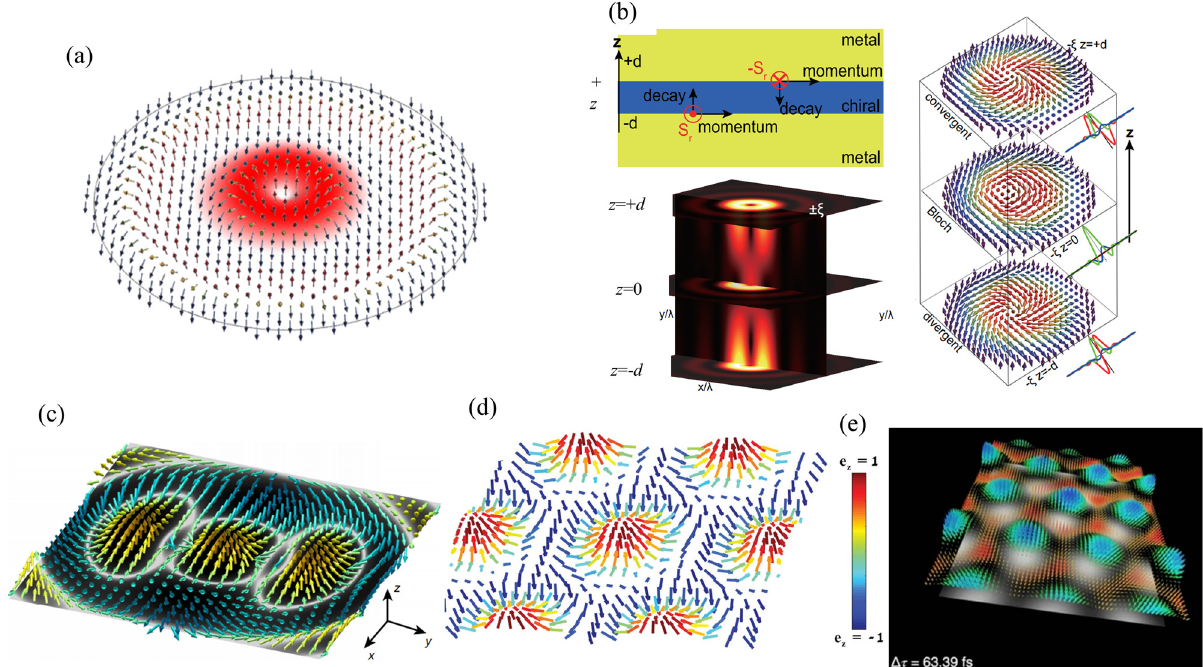
Figure6: Variouskindsof photonictopologicalstructuresinguidedwavesformedinrealspace:(a)Néel-typephotonicspinskyrmionformed in an evanescent optical vortex, for which the spin vector varies progressively from the ‘ up/down ’ state at the center to the ‘ down/up ’ state at the edge (with integer skyrmion number) [75]; (b) Bloch-type photonic spin skyrmion in guided waves introduced into a layer of a chiral materialwhich inducesan E – H coupling[141];(c) meron-like photonicspinstructureina speciallydesignedSPP fi eld [156]; (d)and(e)lattices exhibiting6-foldrotationalsymmetryofdynamic fi eldskyrmionsproducedbyanevanescent fi eldintheabsencespin – orbitcoupling,mapped (d) spatially [154] and (e) temporally